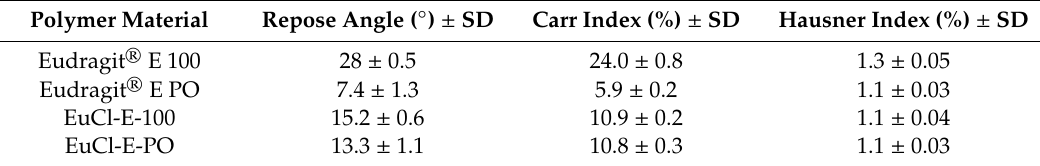
Table 4. Flowability data for polymeric material derived from Eudragit E ®.